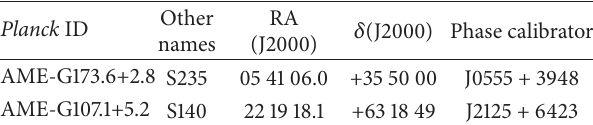
Table 1: The Planck AME candidates observed with the AMI SA and the sources used as phase calibrators.